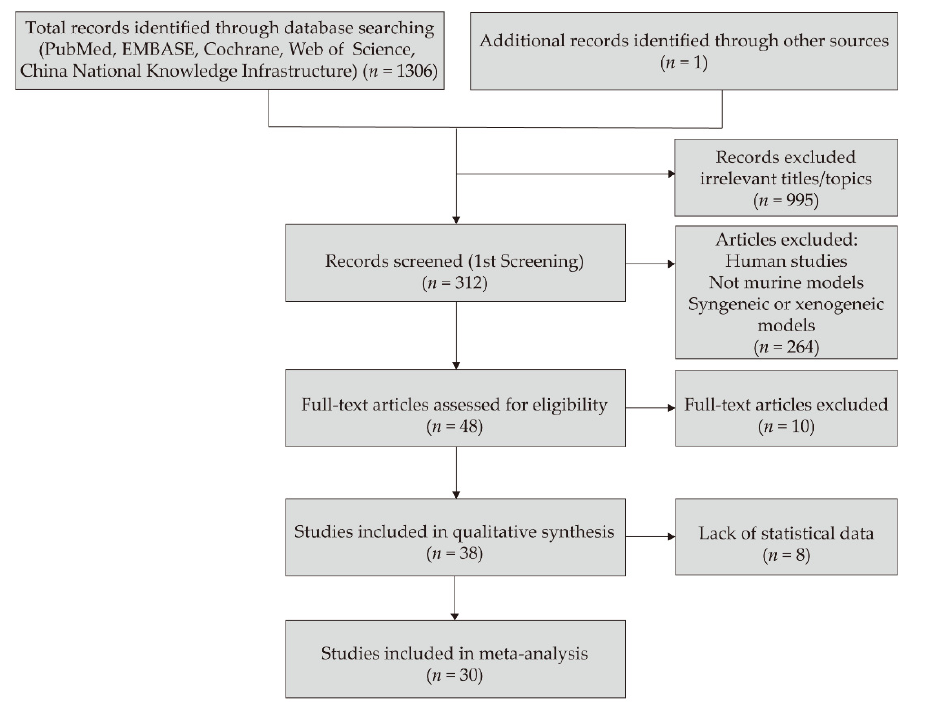
Figure 1. Flow chart of the studies selected for meta-analysis.